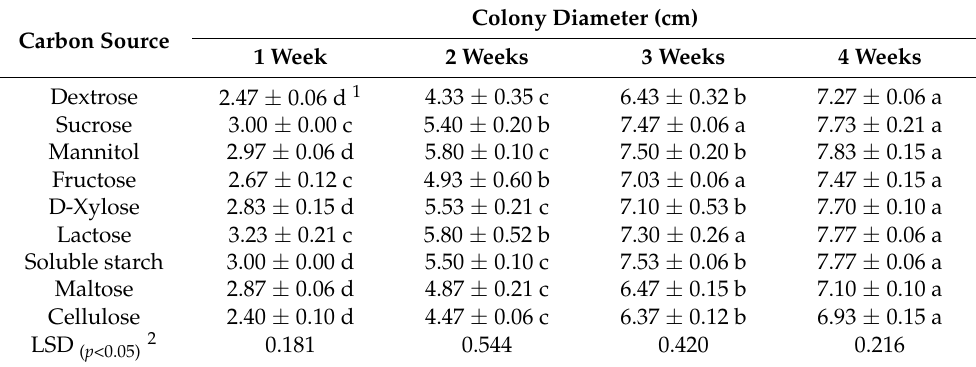
Table 3. Mean ( ± SEM) colony diameter (cm) of Paraphoma radicina measured weekly for four weeks on different carbon sources and at L:D 0:24 h and 25 ◦ C.